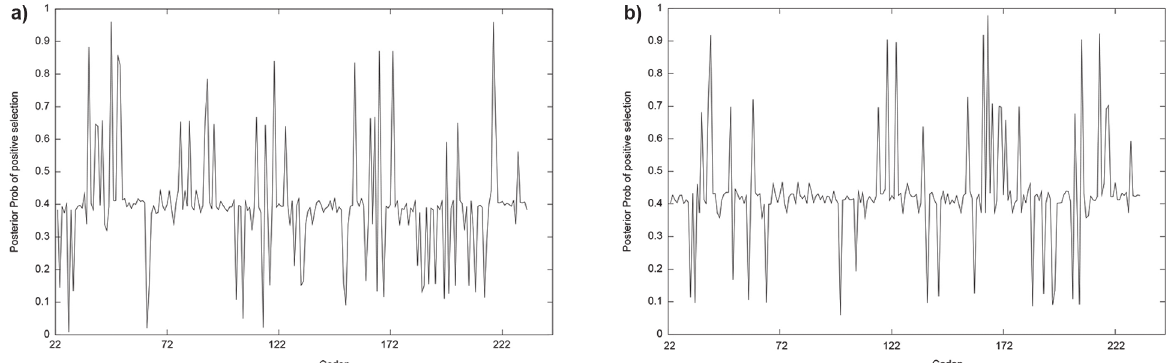
Figure 3 - Posterior probability of codons under selection estimated by FUBAR model (a = Neotropical cichlids; b = African cichlids).